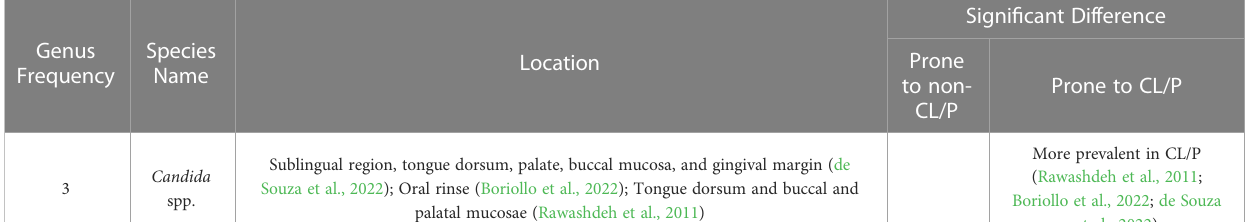
Genus Frequency